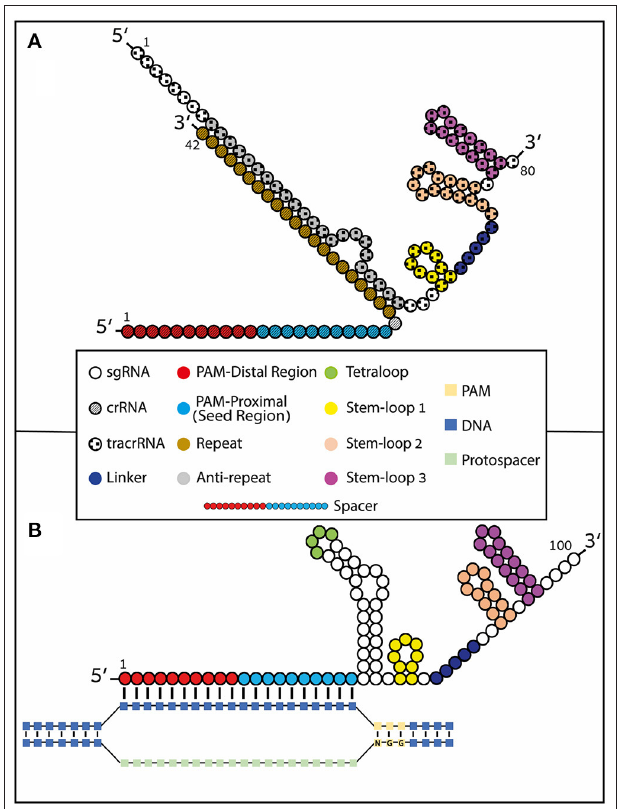
FIGURE 1 | Type II CRISPR formulations. gRNAs contain 4 loop structures: tetraloop (green), Stem-loop 1 (yellow), Stem-loop 2 (orange), and Stem-loop 3 (magenta). Stem-loop 2 and tetraloop do not interact with Cas9 as they protrude from the nuclease (Konermann et al., 2015). The spacer region of the guide undergoes Watson and Crick base pairing with the complimentary stand to the DNA protospacer. The spacer region (also known as guide region) is typically 20 nucleotides long but it has been shown that it can be shortened or lengthened (to include hairpin structures) at the 5 ′ end. The spacer region can be divided into two regions: the PAM-proximal (seed) region and the PAM-distal region. (A) Naturally occurring crRNA [ ∼ 42 nt (striped nucleotides)] containing the DNA-binding spacer sequence and the trans-activating tracrRNA [80 nt (Rahdar et al., 2015) (checkered nucleotides)] annealed together through Watson and Crick base-pairing by the repeat (brown) and anti-repeat (gray) regions. (B) Synthetic sgRNA formulation where the crRNA and tracrRNA are covalently fused by a tetraloop. R-loop formation is depicted with Watson and Crick base pairing of the RNA:DNA